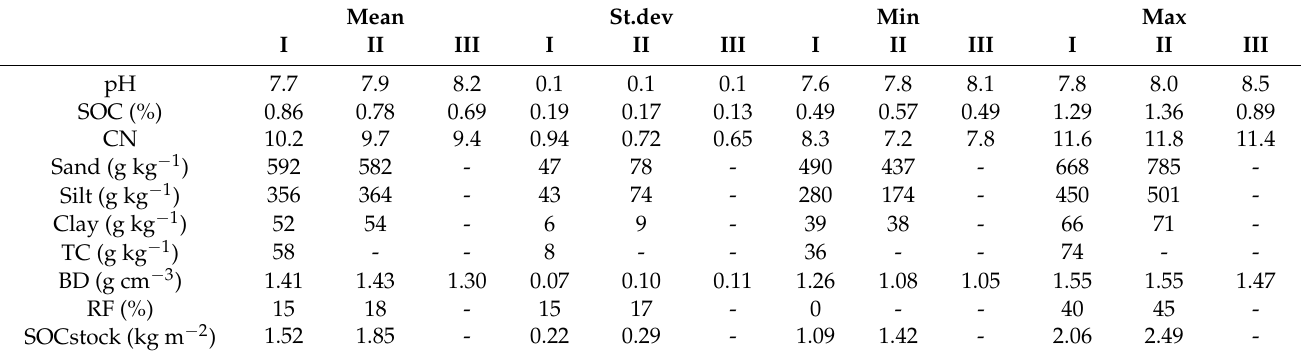
Table 1. Main statistics of initial soil properties of the investigated layers (I: 0–15 cm; II: 15–35 cm; and III: 35–60 cm). Mean St.dev